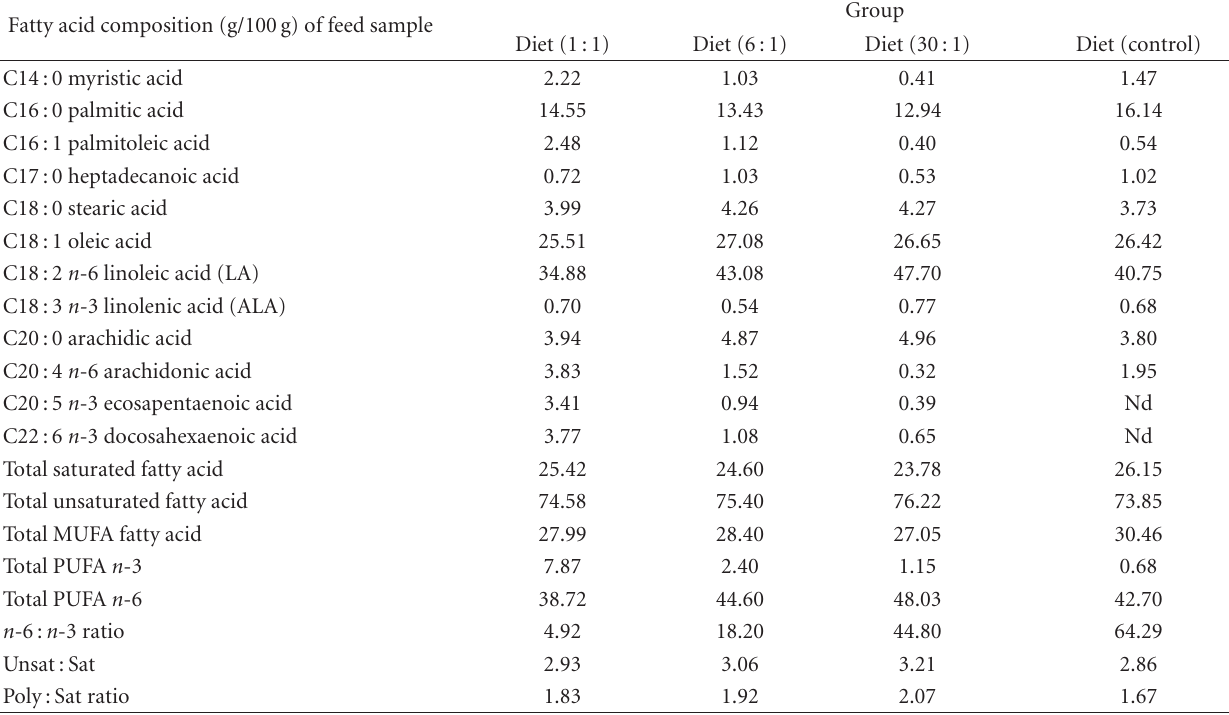
Table 1: Fatty acid composition (g/100g total fatty acids) of the treatment diets ( n = 3). Fatty acid composition (g/100g) of feed